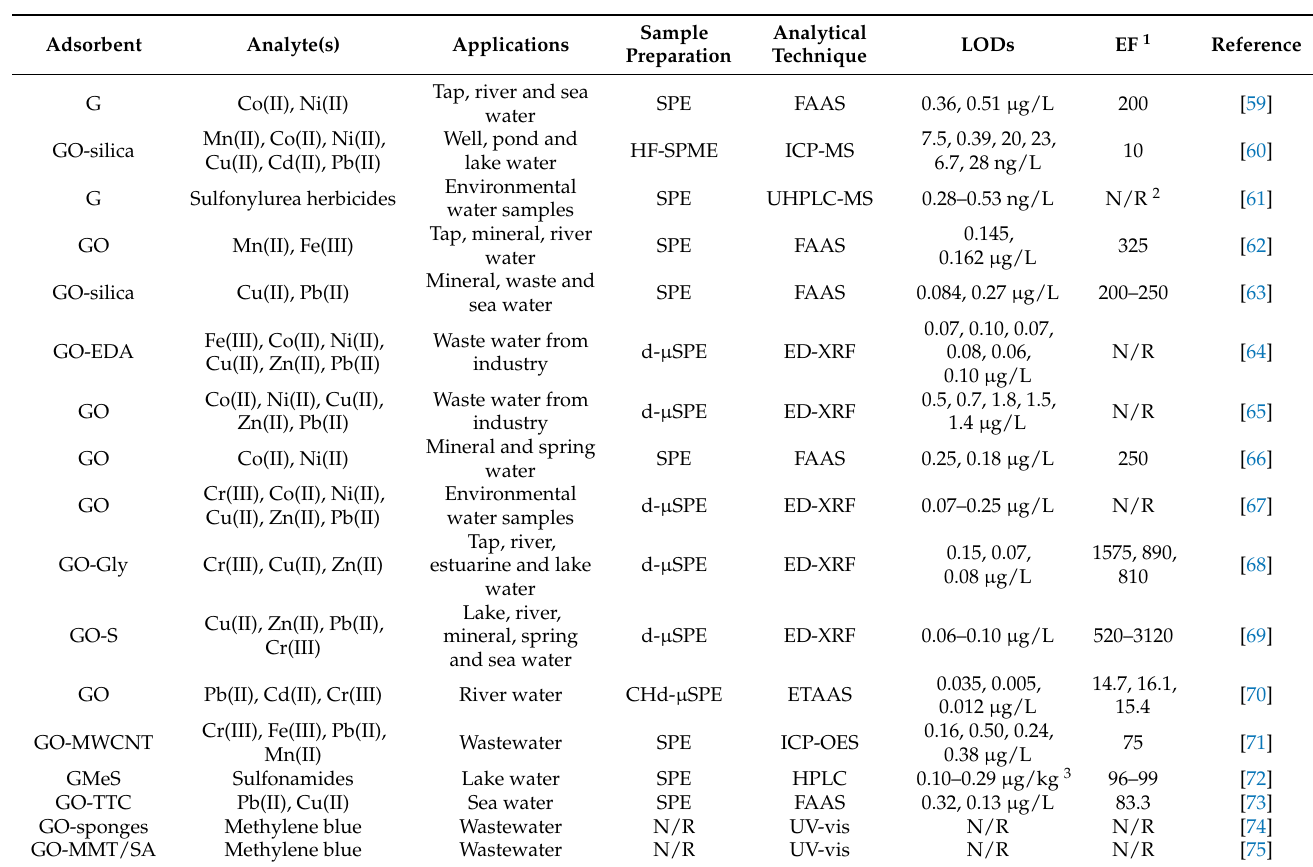
Table 1. Recent applications of graphene-based nanomaterials in environmental